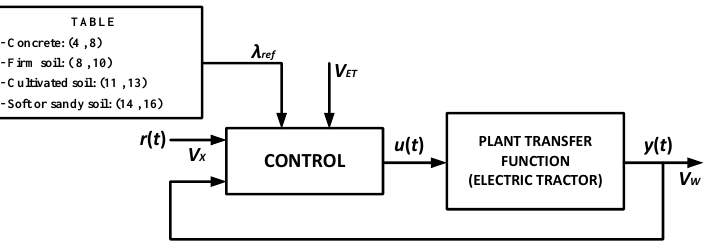
Figure 2. Slip control system applied to an electric tractor. gitudinal dynamics using a PI controller. Figure 3 represents the block diagram of the slip control system, where V 1 and V 2 are the reference velocities applied to the inverter respon- sible for driving the motors.